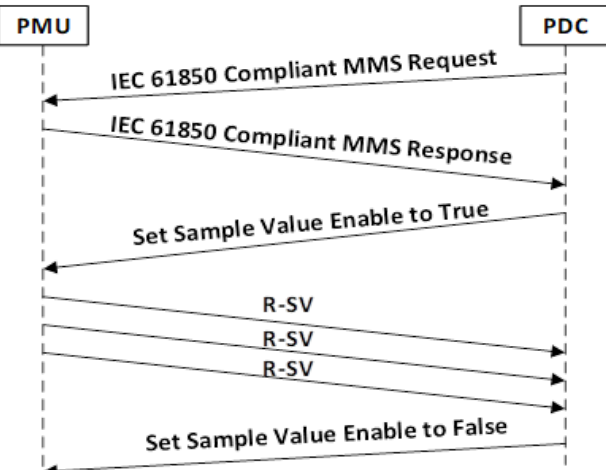
Figure 2. Exchange of IEEE C37.118 messages between the PMU and PDC.